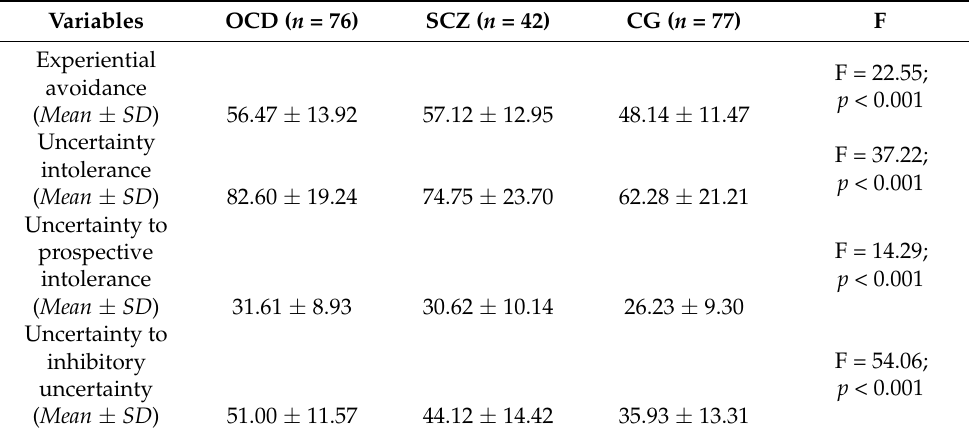
Table 3. ANOVA in experiential avoidance and uncertainty